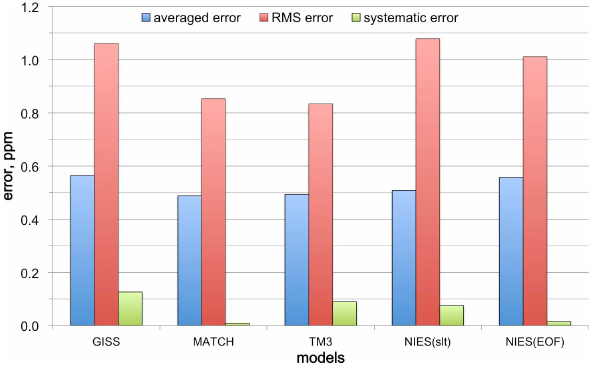
Fig. 7. Averaged error, RMS error, and systematic error between observations and model simulations of CO 2 distributions for differ- ent transport models, and experiments with NIES model using EOF approach (last case) described in the